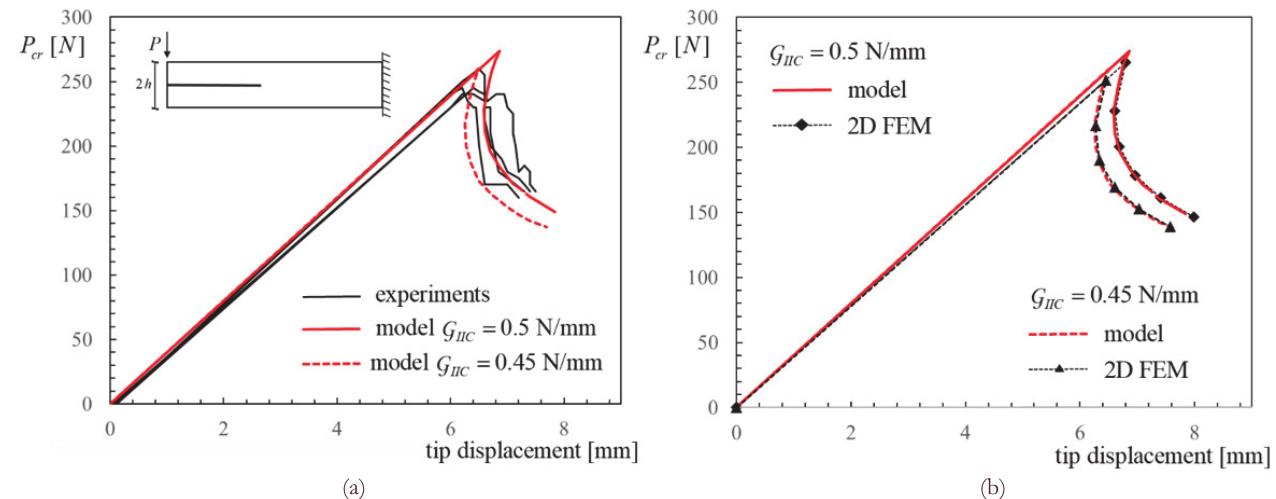
Figure 6: (a) Critical load for crack propagation versus load point displacement in the ELS specimen tested in [28] . Geometry and materials: L = 130 mm, 2 h = 5.98